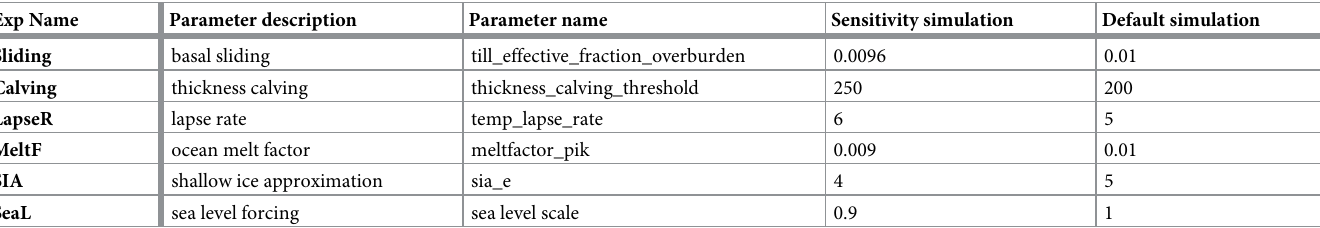
Table 1. List of ensemble simulations in this